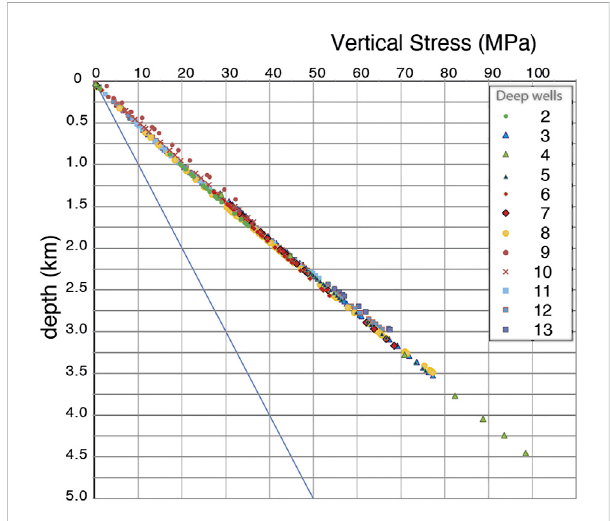
FIGURE 3 Vertical stress magnitude vs. depth estimated from the lithostatic load in 12 wells. The lithostatic gradient ranges from 21 to 23 MPa/km. The blue line is hydrostatic pressure. Depth refers to ground level for on-land wells and sea level for offshore